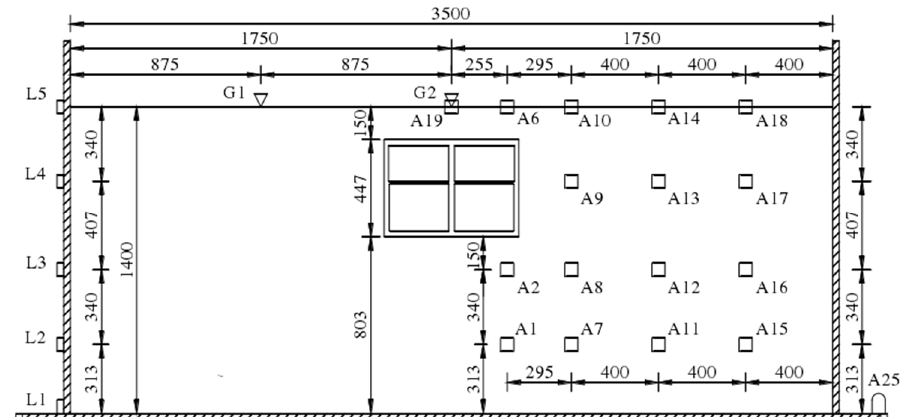
Figure 9. Sensor layout (dimensions: mm).